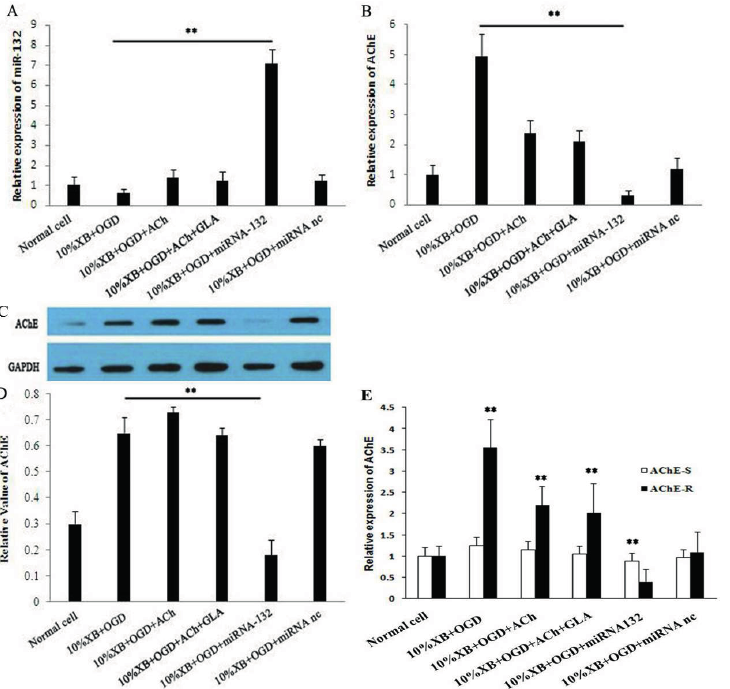
Figure 5: Investigation on the regulatory mechanism of miRNA-132 on the inflammatory pathway in rat renal macrophages of the hypoglycemia and hypoxia groups by testing (A) the relative expression of miRNA-132 in macrophages by using quantitative PCR, (B) the relative expression of AChE mRNA in renal macrophages, (C) the relative expression of AChE protein in renal macrophages, (D) The expression level of AChE protein was quantitatively analyzed, and the results are presented as mean ± SD, * P < 0.05, ** P <